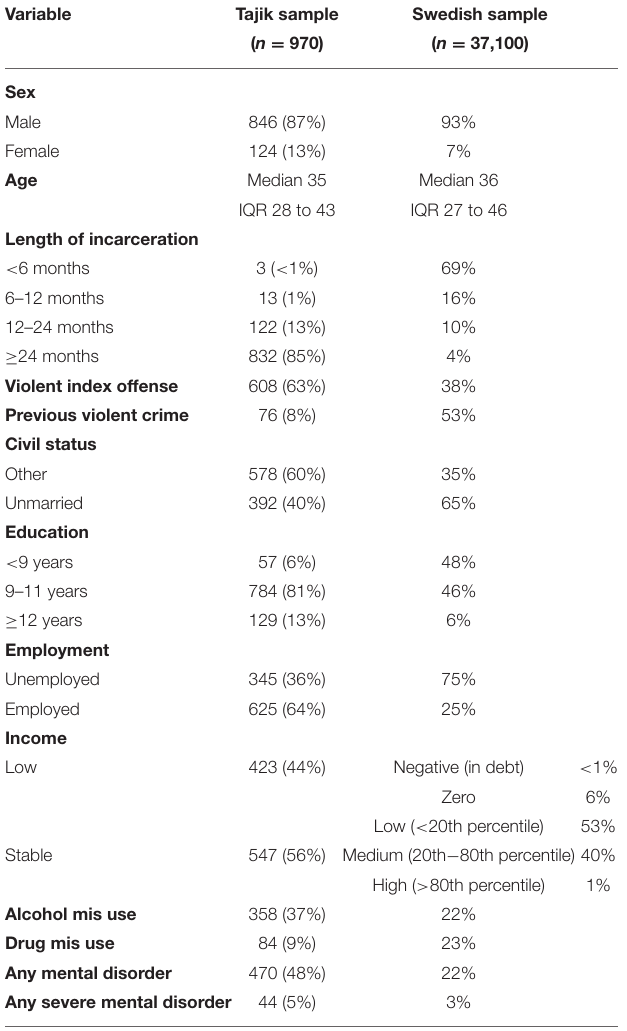
TABLE 1 | Baseline characteristics of the Tajik sample compared with those of the Swedish sample.